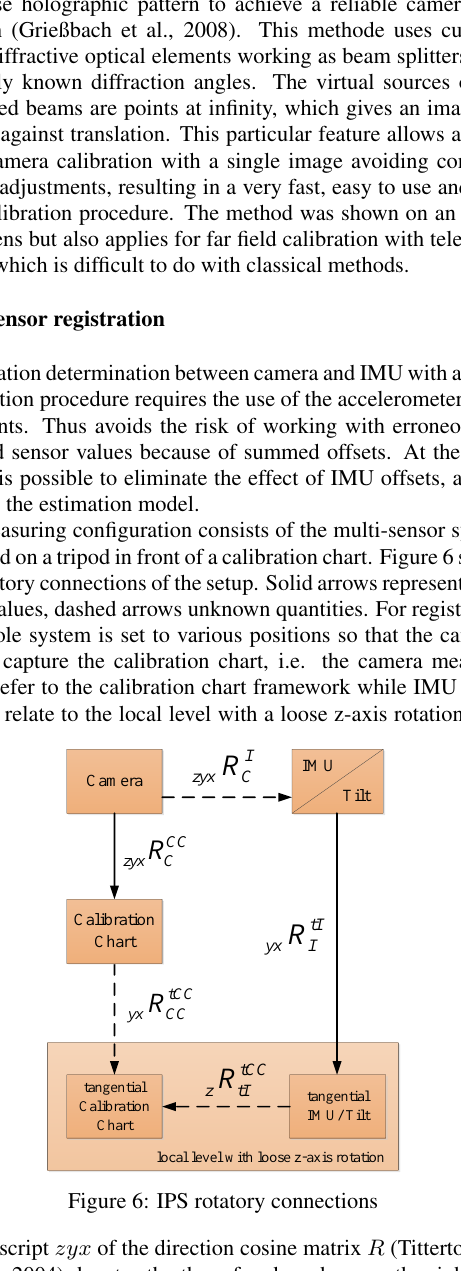
bration chart ( CC ). zyx R CC